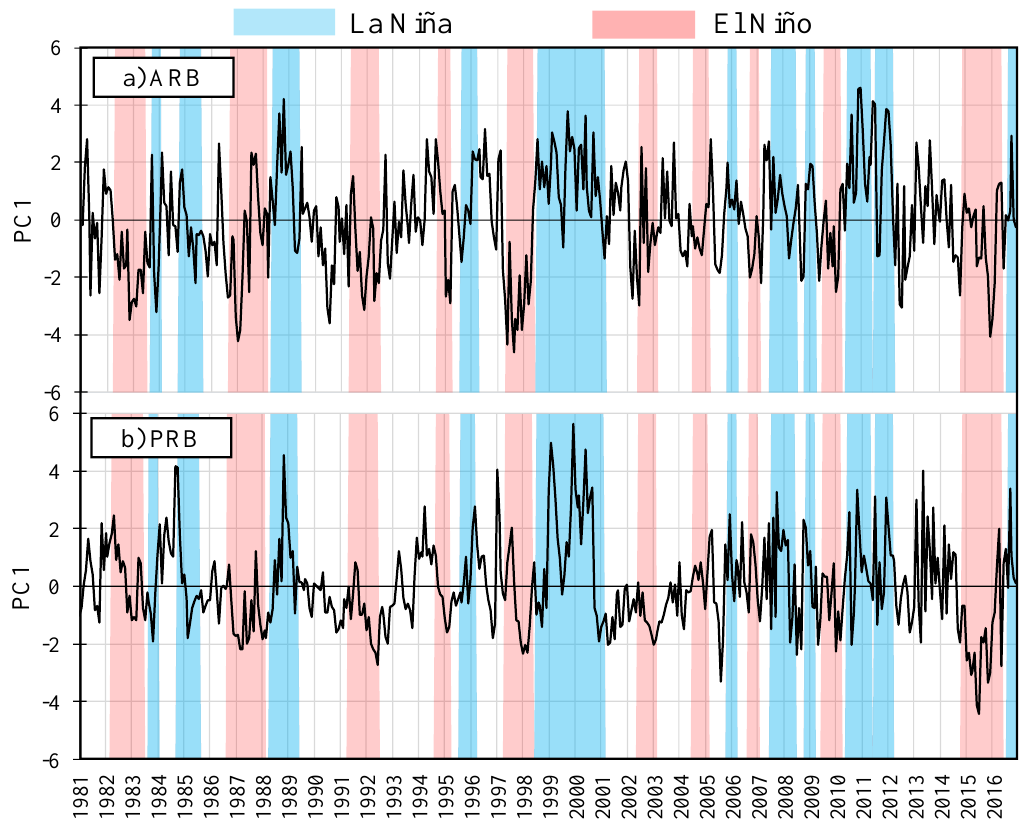
Figure 3. The 1981 – 2016 time series of the principal components for ( a ) Atrato River Basin (ARB) and, ( b ) Patía River Basin (PRB).